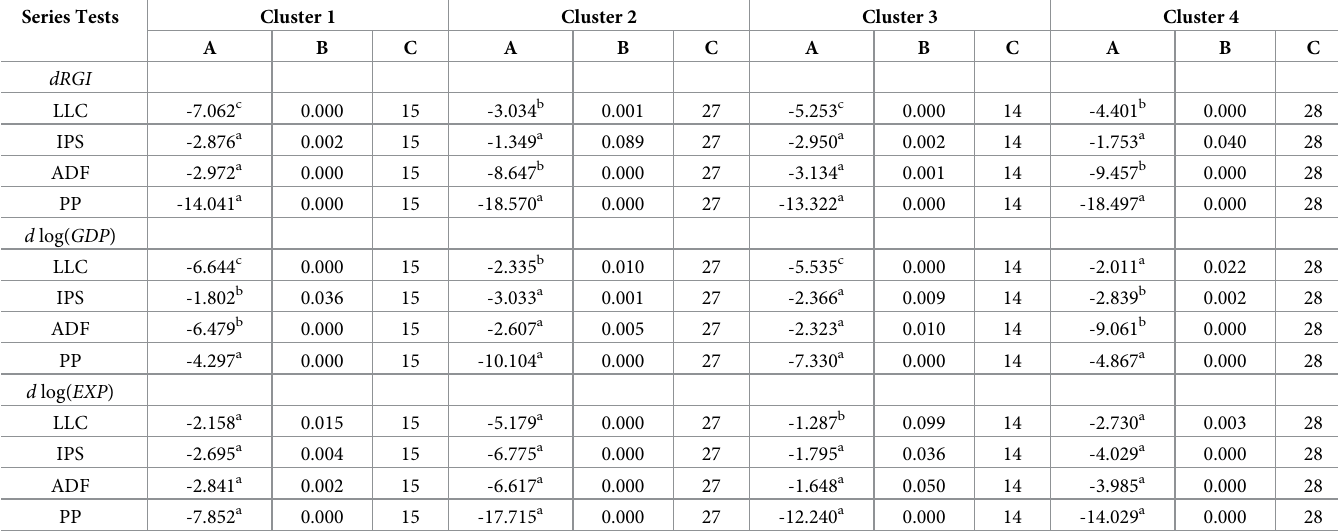
Table 6. Unit root test results of four cluster variables—1st difference series.